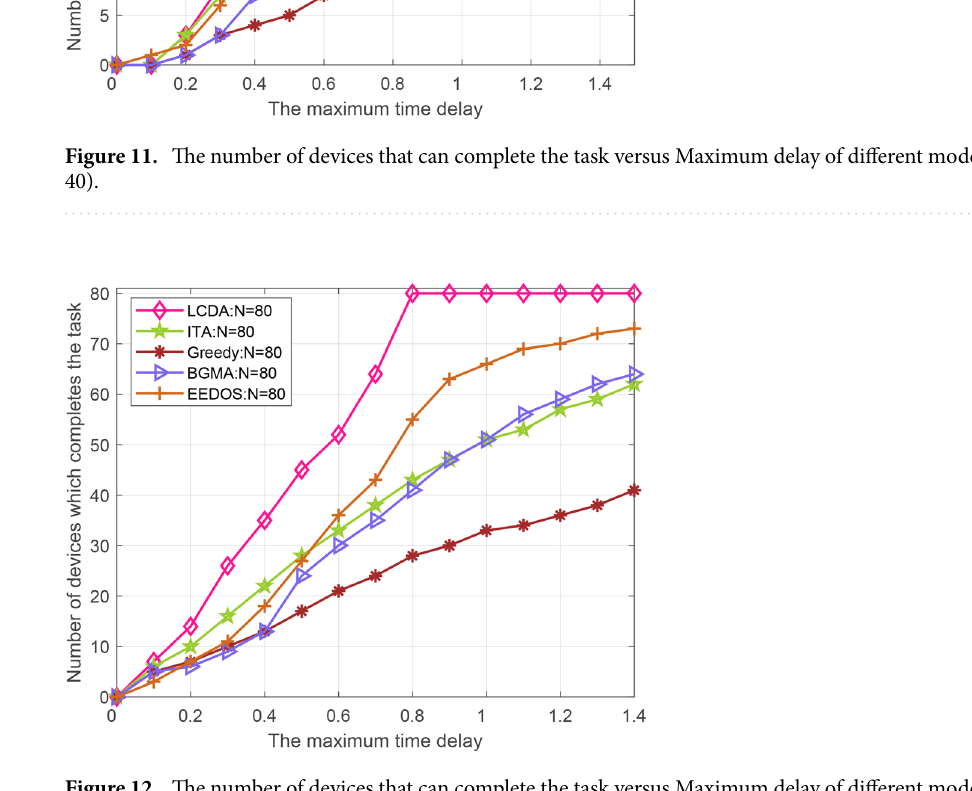
Figure 12. The number of devices that can complete the task versus Maximum delay of different modes (N =